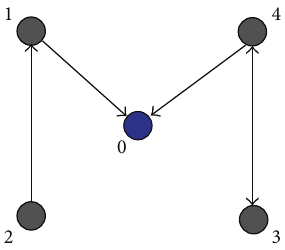
⃗ V ( ⃗ G ) = {0, 1, 2, 3, 4} Figure 6: